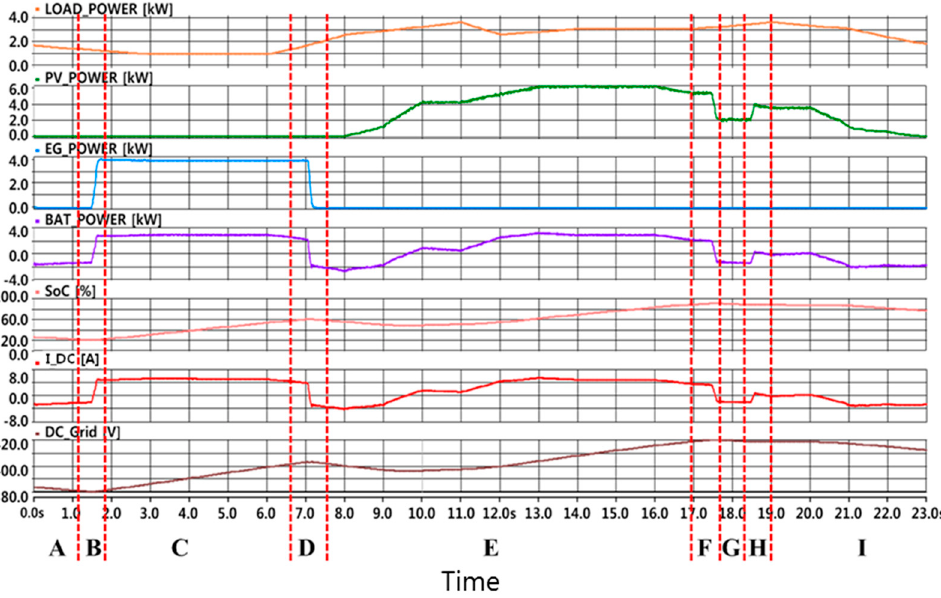
Figure 10. Simulation results using proposed operation scheme.